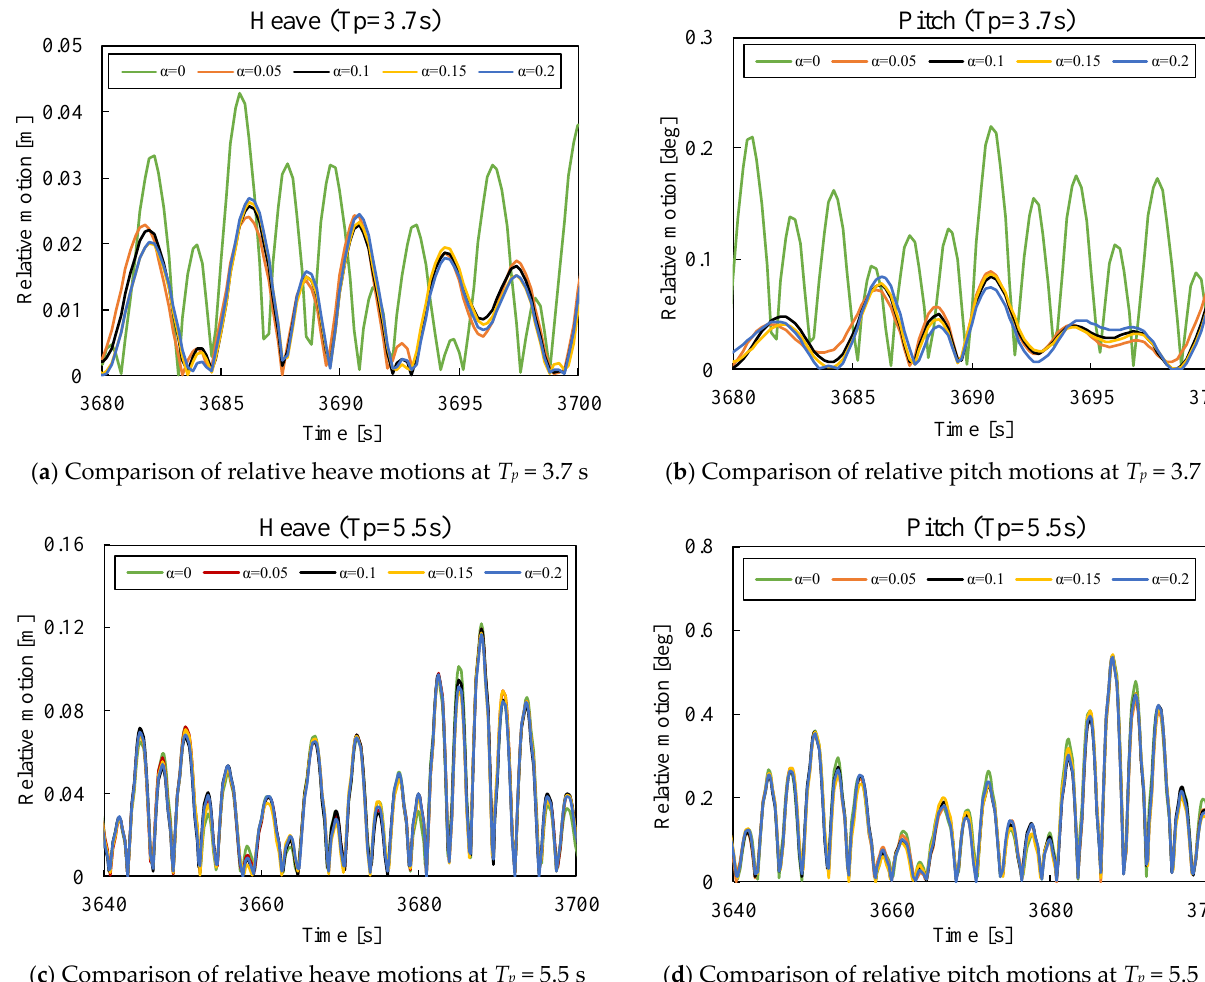
( a ) Comparison of relative heave motions at T p = 3.7 s ( b ) Comparison of relative pitch motions at T p = 3.7 s ( c ) Comparison of relative heave motions at T p = 5.5 s ( d ) Comparison of relative pitch motions at T p = 5.5 s Figure 21. Time-domain responses under two irregular waves. Figure 21. Time-domain responses under two irregular